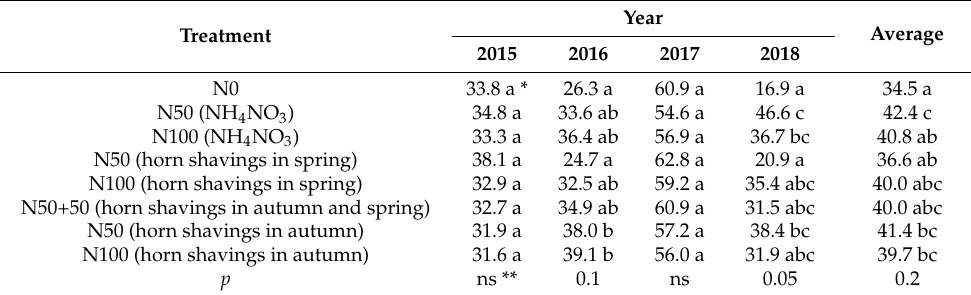
Table 4. Fertiliser effect on Ligol apple tree yield